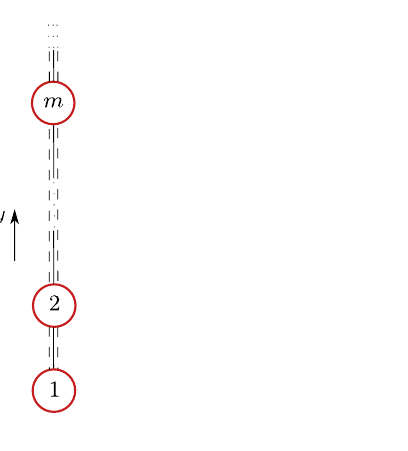
Figure 6 . Field theory living in the D4’-NS5’-D6 subsystem (in units of Q D 6 = 1 ) in terms of 2d (0,4) multiplets. Red circles represent (4,4) vector